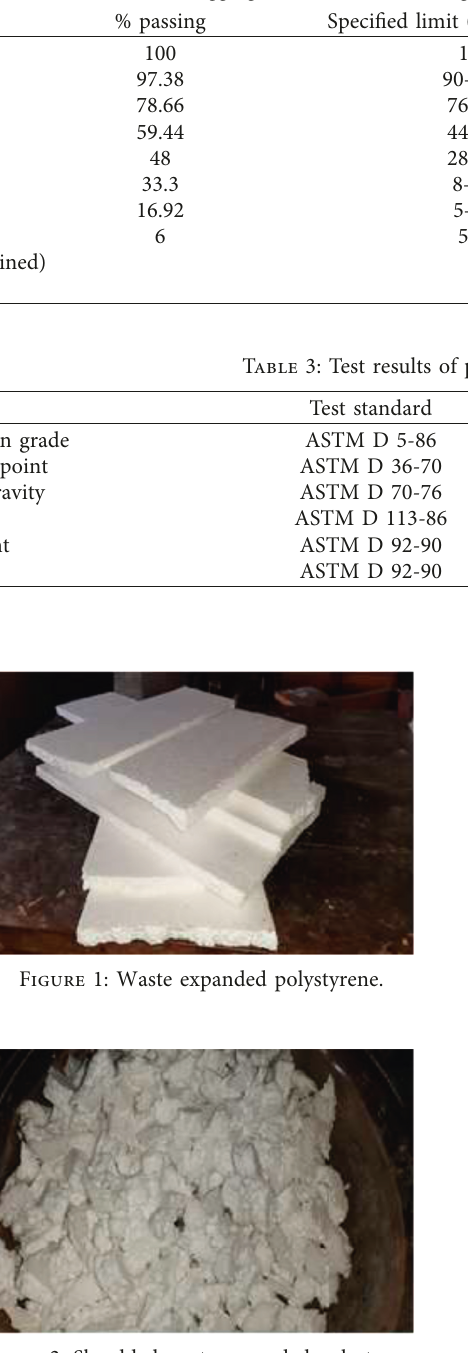
Figure 2: Shredded waste expanded